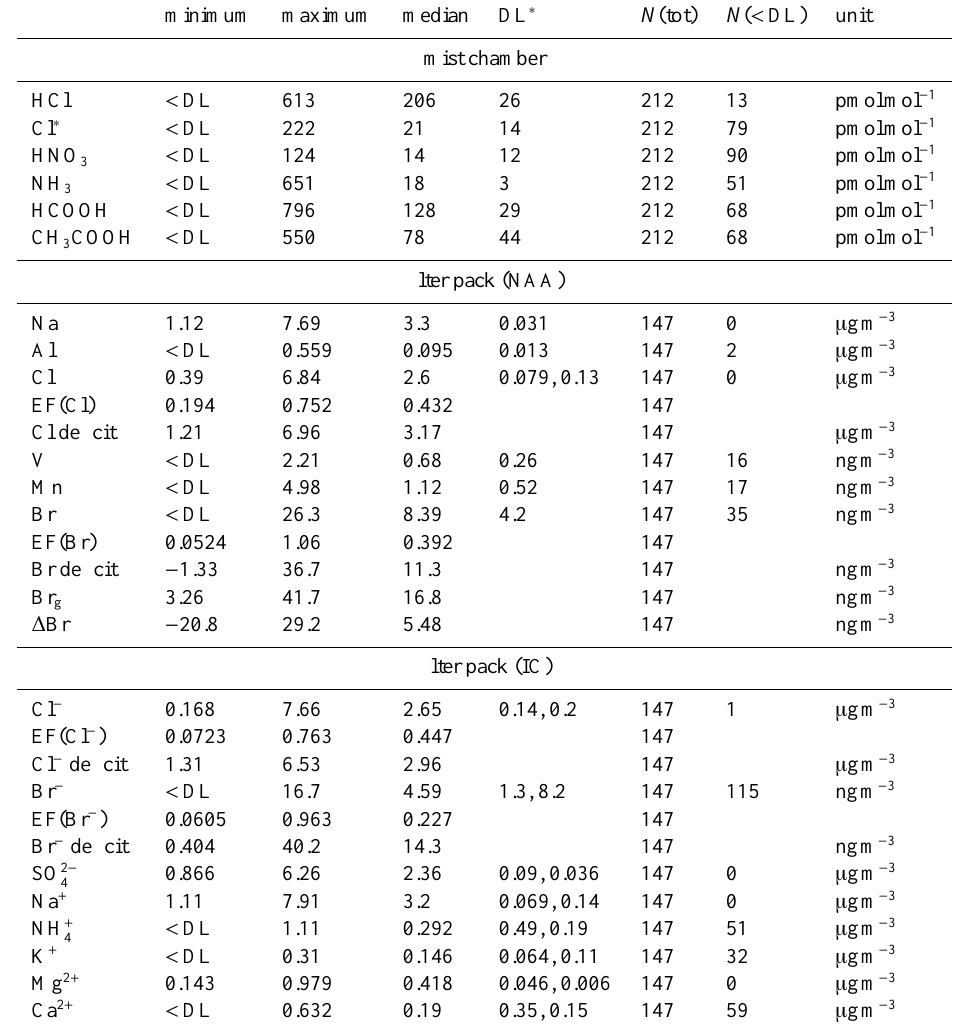
Table 1. Data summary. Here, DL is the detection limit. N (tot) and N ( < DL) are the total number of data points and the number below the DL,